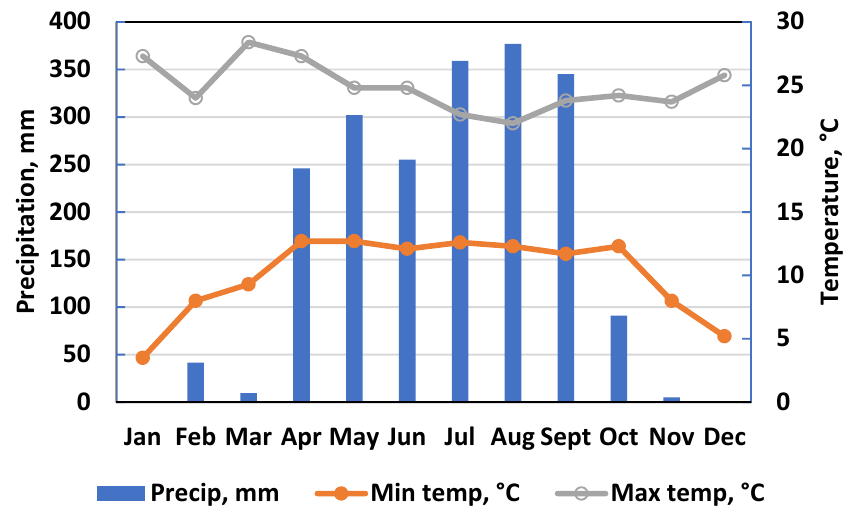
Figure 1. Mean monthly rainfall (Precip) and minimum (Min temp) and maximum temperature (Max temp) of the study area during the experimental season.